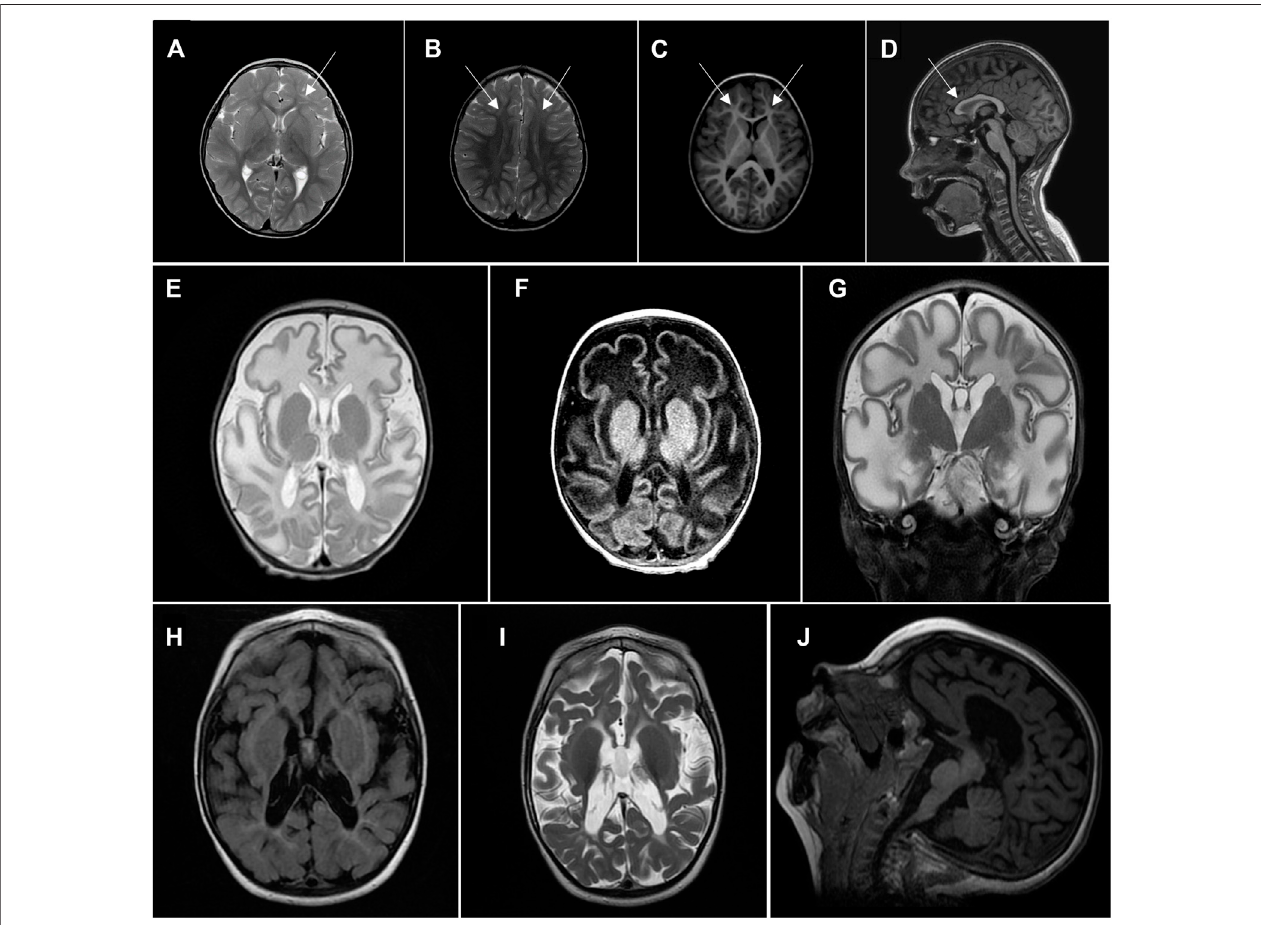
FIGURE 1 | Head MRI. (A – D) Proband 1, 6 years of age. (A) , (B) — axial T2, frontal subcortical hyperintensity. (C) — axial T1, white matter reduction in frontal lobes. (D) — sagittal T1, smaller anterior parts of corpus callosum. (E – G) Proband 2, 5 weeks of age, showing signi fi cant diffuse white matter abnormalities sparing basal ganglia. (E) — axial T2, (F) — axial T1, (G) — coronal T2. (H – J) Proband 2, 2 years of age, showing a diffuse severe cotico-subcortical atrophy with white matter abnormalities but with progression of myelination. (H) — axial T2 fl air, (I) — axial T2, (J) — sagittal